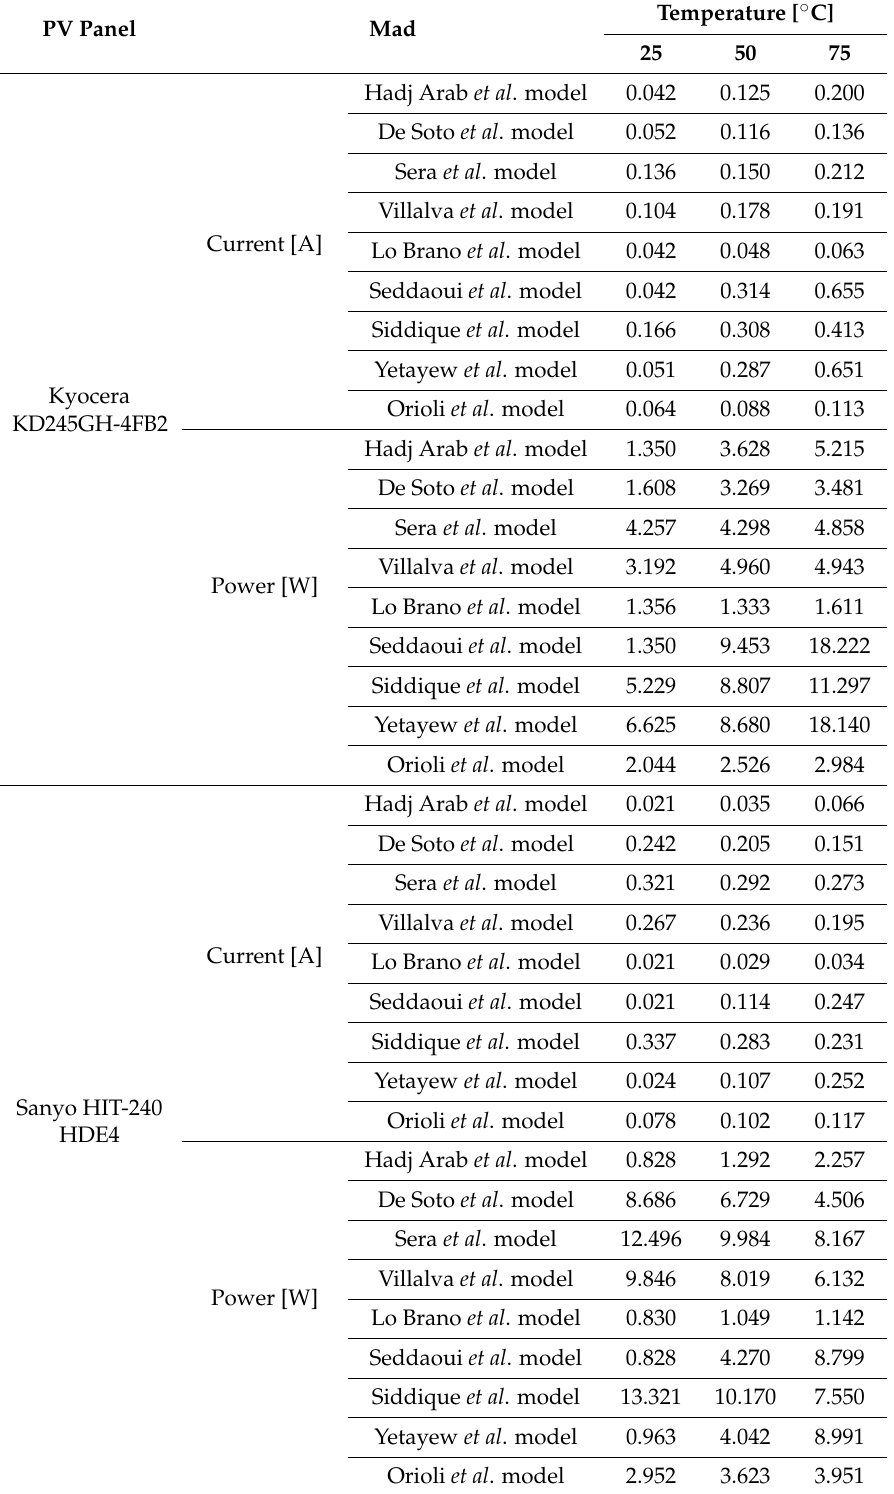
Table 6. Mean absolute current and power differences between the calculated andthe issued I–V characteristics at irradiance G = 1000 W/m 2